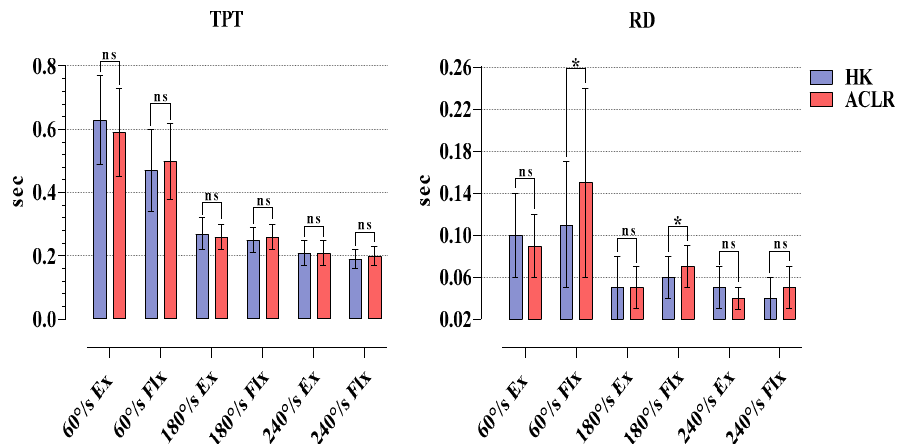
Figure 4. Comparison of TPT and RD values obtained in isokinetic tests for HK and ACLR. ns, nonsignificant; * p < 0.05; HK, healthy knee; ACLR, anterior cruciate ligament reconstruction knee; H/Q, hamstring/quadriceps; Ex, extension; Flx, flexion.